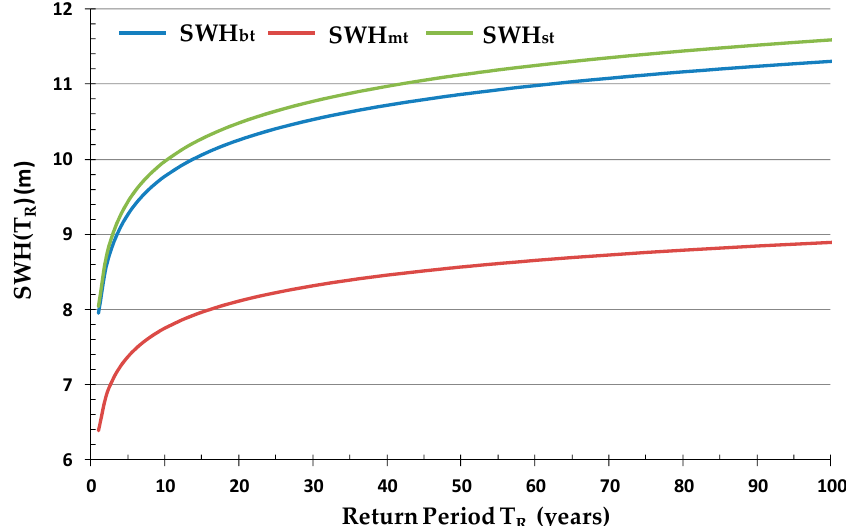
Figure 2. Example of results for test location on the site of buoy 46014 along US Pacific Coast: SWH bt is the curve computed from experimental data; SWH mt is the curve computed from model data; SWH st is the estimated curve, obtained through the integrated procedure.